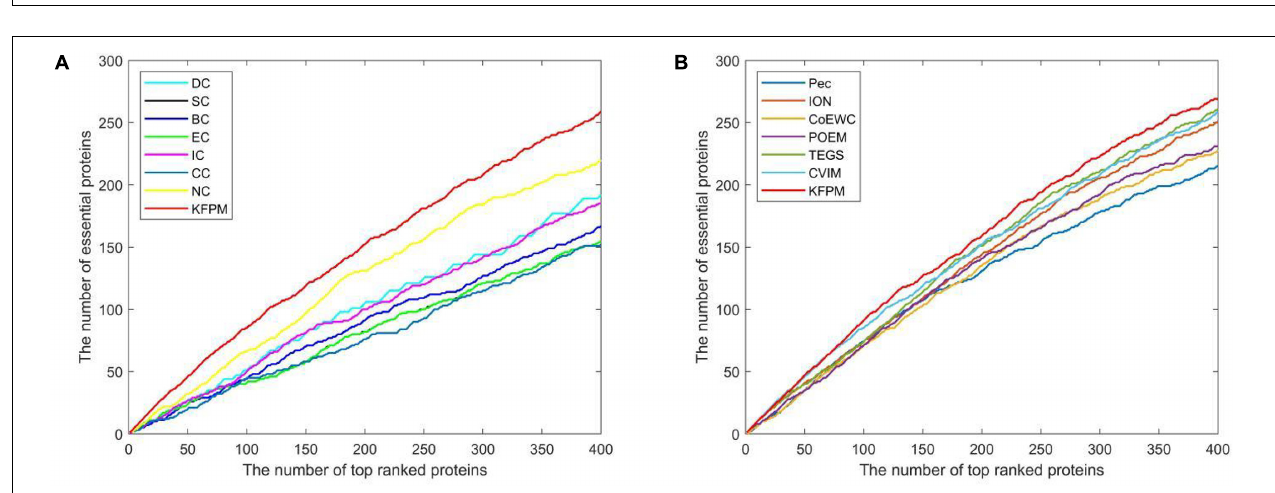
FIGURE 4 | Performance comparison between KFPM and 13 state-of-the-art methods based on the method of Jackknife under the DIP database. (A) Comparison between KFPM and DC, SC, BC, EC, IC, CC, NC. (B) Comparison between KFPM and Pec, CoEWC, POEM, ION, TEGS, CVIM.